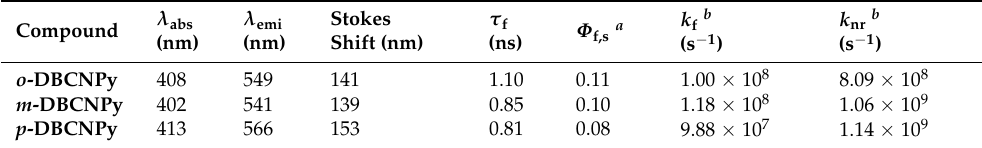
Figure 2. Fluorescence emission spectra of o -DBCNPy ( a ), m -DBCNPy ( b ), and p -DBCNPy ( c ) in 1 × 10 − 5 M solutions (THF, tetrahydrofuran; DCM, dichloromethane; DMF, N , N -dimethylformamide); the plot of Stokes shifts of the three isomers in different solvents versus solvent orientation polarizability ( Δ f ) ( d ). Table 1. Photophysical data of the isomers in 1 × 10 − 5 M THF